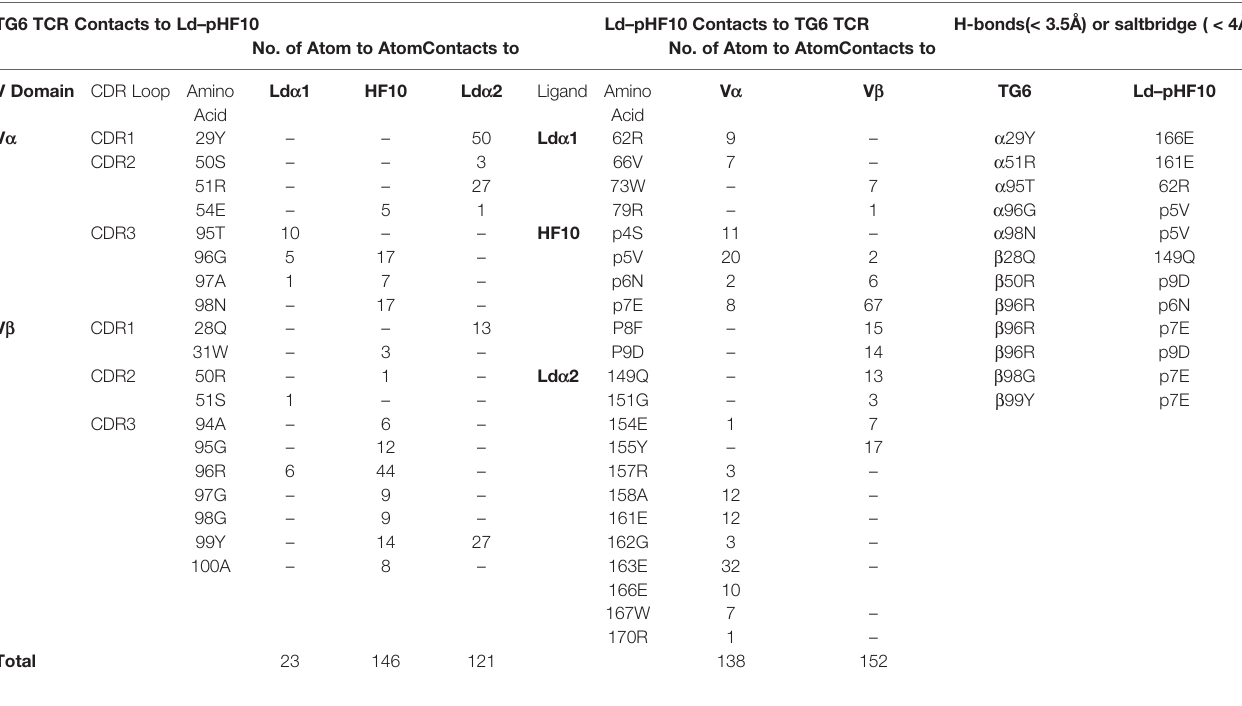
TABLE 1 | Contacts between TG6 TCR and Ld – pHF10.